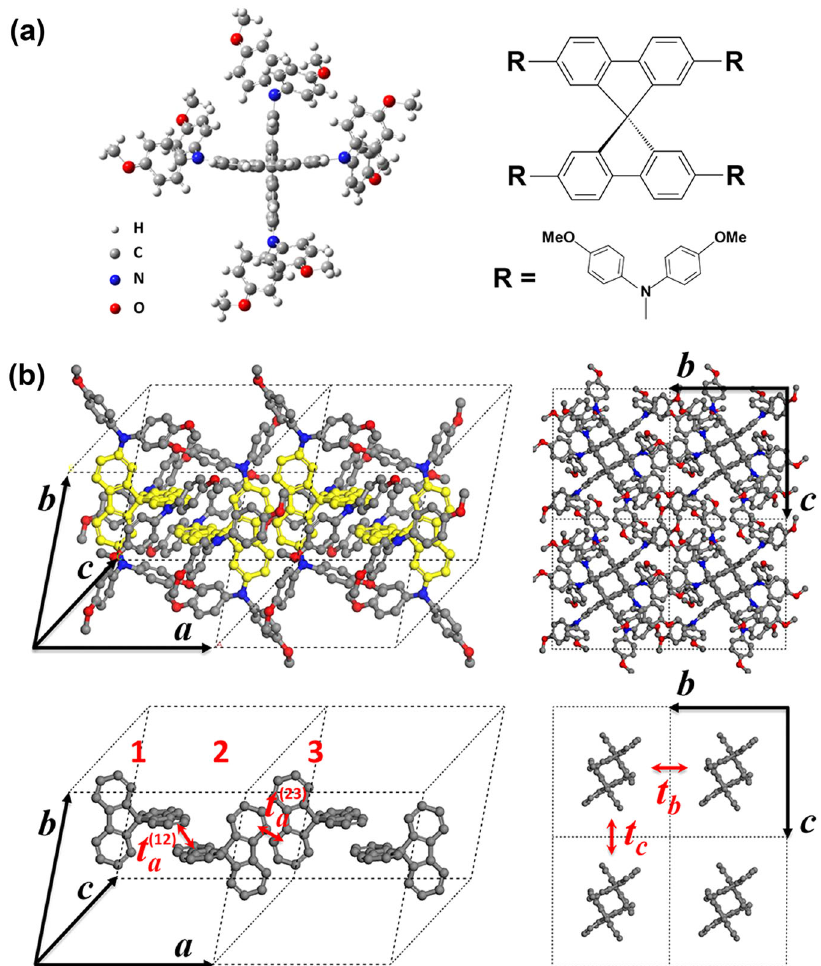
Fig. 1 a Molecular and chemical structures of spiro-OMeTAD; b crystal structure of the spiro-OMeTAD single crystal 17 (upper panels) and illustration of the stacking of the molecular skeletons, as well as the molecular pairs leading to major transfer integrals (lower panels). In the upper-left panel of b , the bi fl uorene skeleton of each spiro-OMeTAD molecule is highlighted in